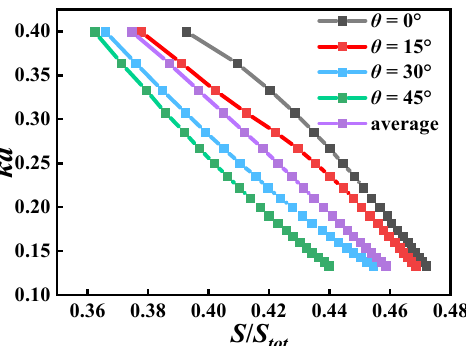
Figure 4. The relation between area ratio and dimensionless curvature when GB and curvature calculation region are at different relative positions. Table 2. The fitting parameters of area ratio and dimensionless curvature. Relative Angle